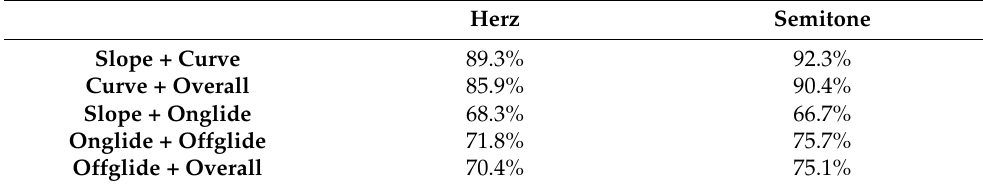
Table 6. Tone recognition rates using f 0 profile features based on SVM